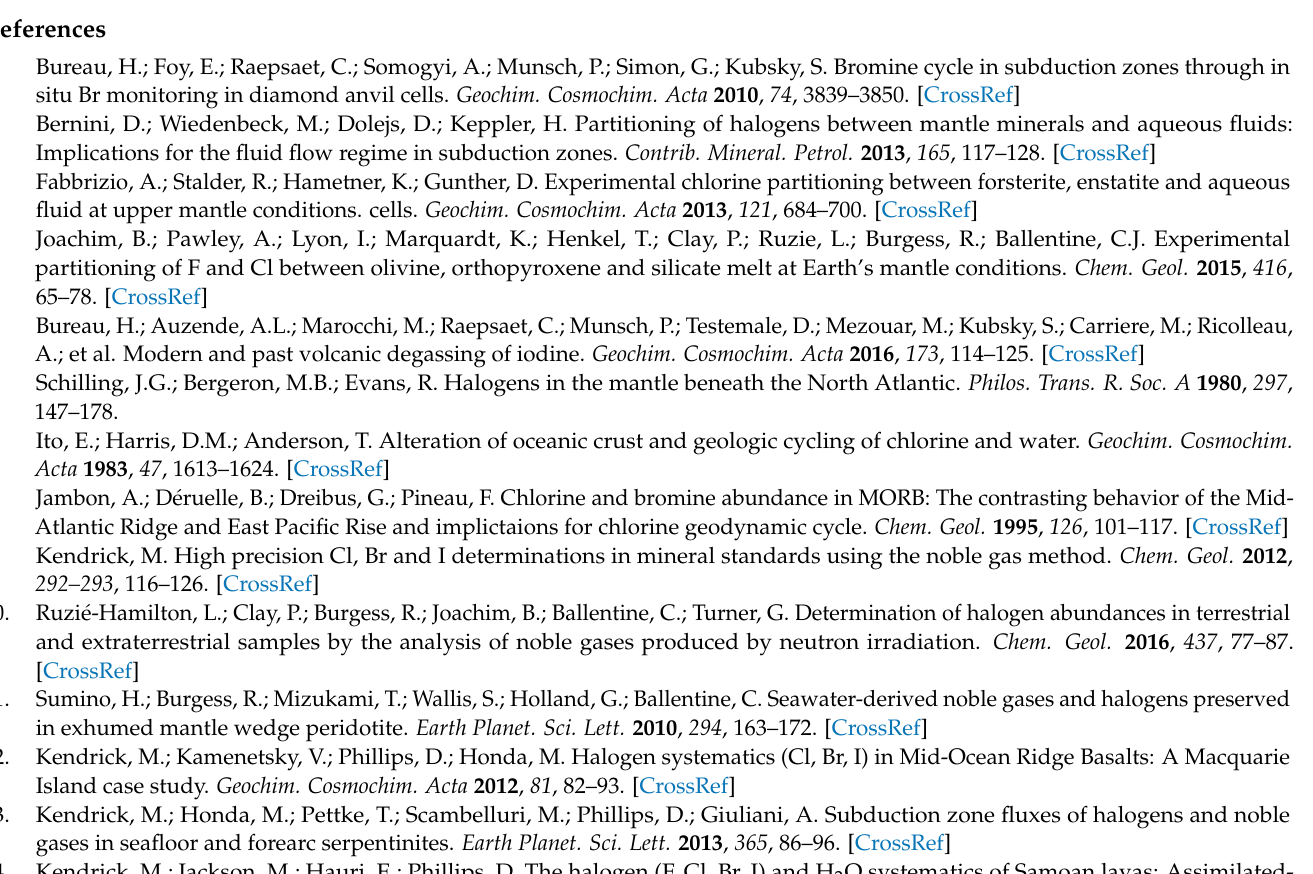
Table S2. Halogen concentrations and ratios measured via NI-NGMS, plus K, Ba and U data; Table S3. TOF-SIMS secondary ion maps; Table S4. Bulk rock chemistry as determined by EPMA data and modal min-eral abundances; Table S5. Average mineral compositions based on EPMA data, with modal abundances in the respective rock sample; Table S6. Årsheimneset EPMA data; Table S7. Svart-berget EPMA